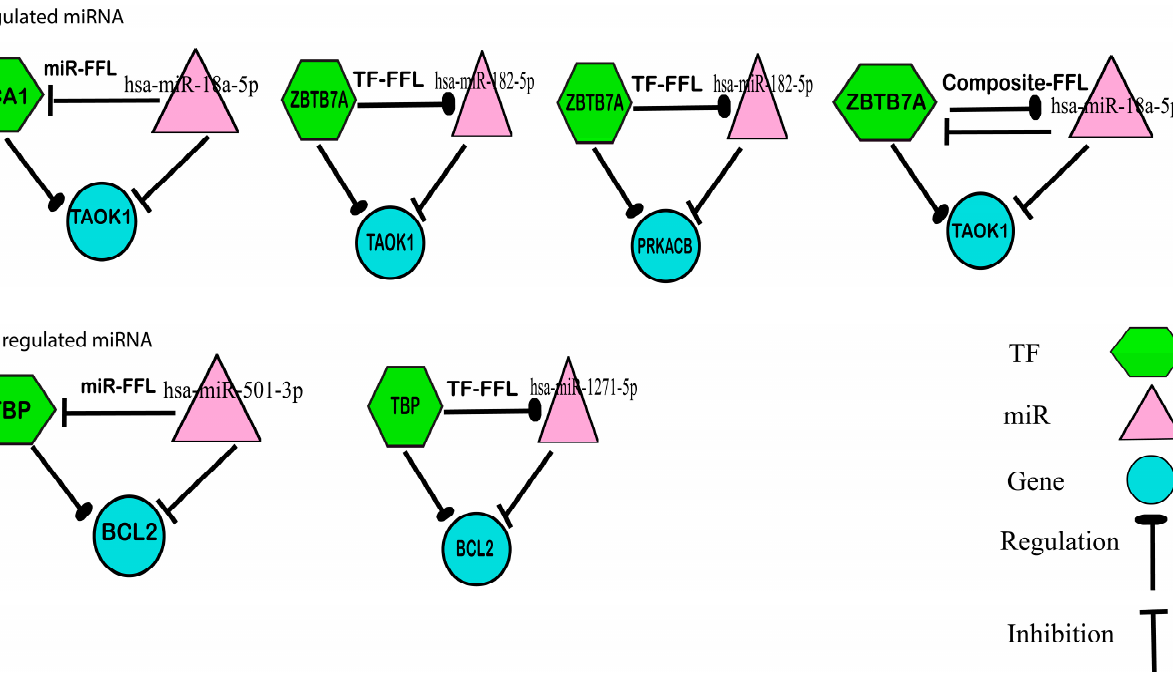
Figure 7. The biological connectivity between genes, miRNAs, and transcription factors.